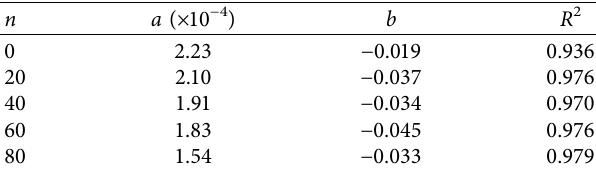
Table 2: Changing rules of parameters a and b